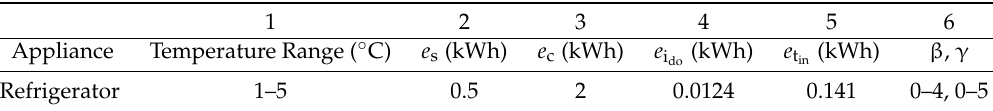
Table 5. Refrigerator parameters [33,35].